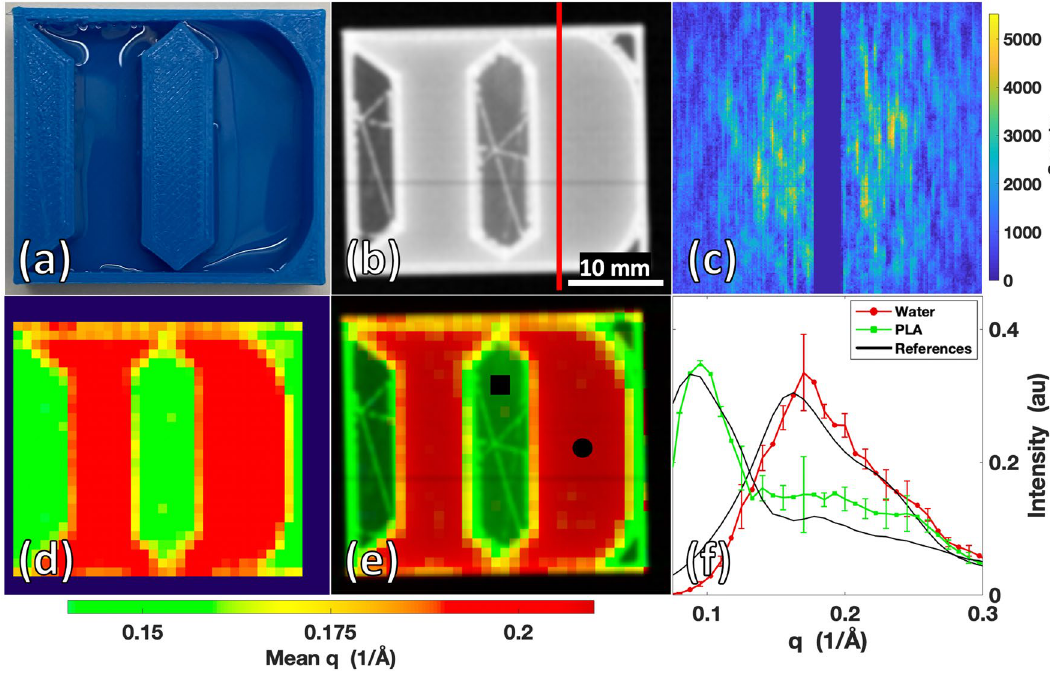
Figure 3. Duke D phantom composed of PLA plastic and water scanned by the X-ray fan beam coded aperture imaging system. ( a ) Photograph of Duke D phantom. ( b ) Transmission scan of Duke D Phantom. ( c ) Multiplexed XRD data acquired when fan beam was at the location of the red line in ( b) . ( d ) XRD image with artificial coloring based on the mean momentum transfer (q) value of each voxel’s XRD spectrum. ( e ) Combined transmission + momentum transfer (q) colorized (TQC) image of Duke D. ( f ) Mean XRD spectrum obtained from the marked 3 × 3 voxel regions in ( e ) (with standard deviation bars), compared against the XRD spectrum of PLA and water measured in a commercial